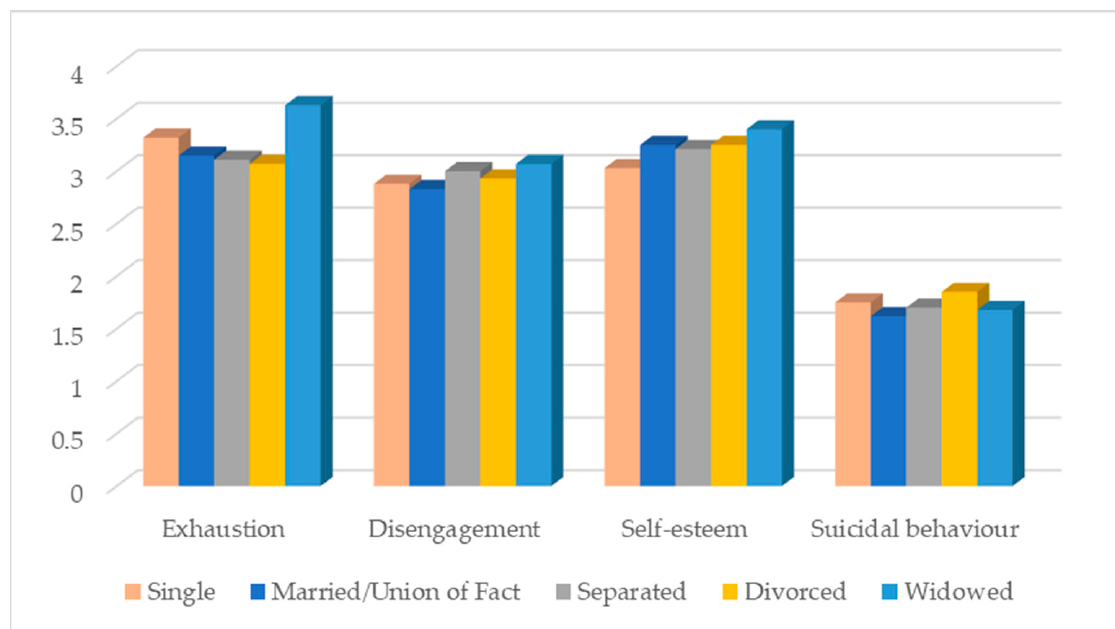
Figure 5. Distribution of the variables under study according to marital status .